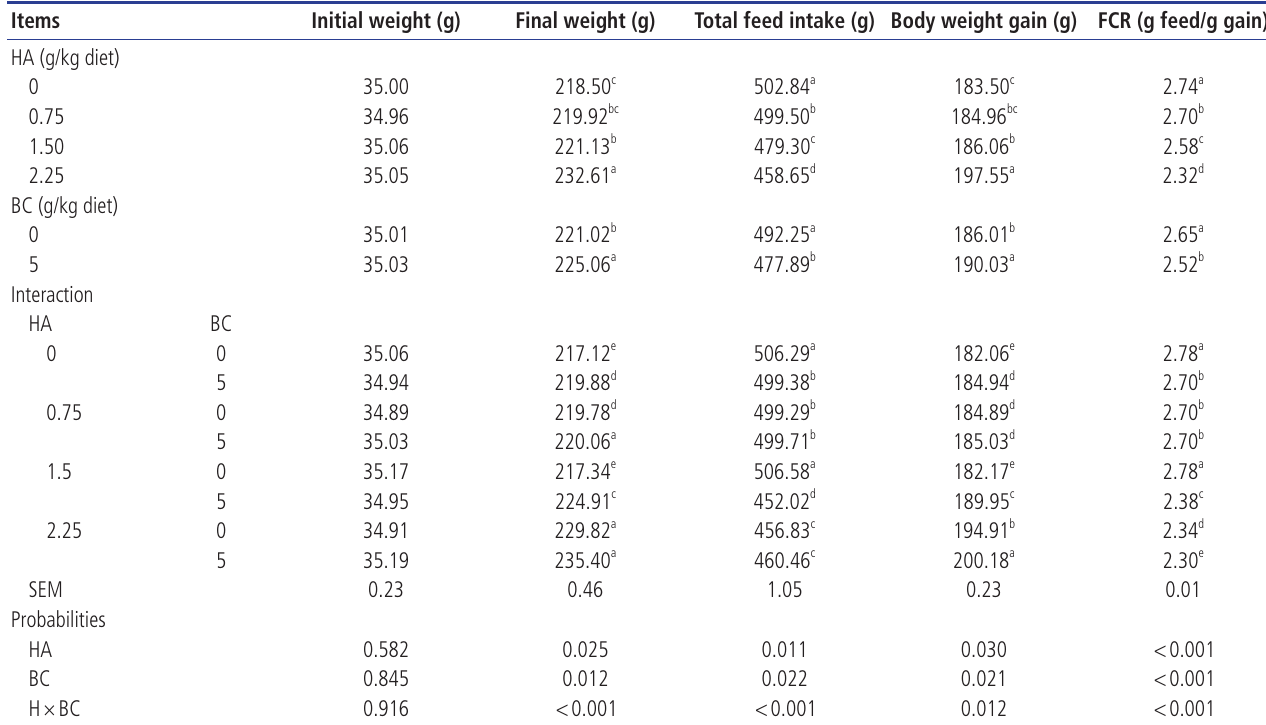
Table 2. Effect of dietary treatments on growth performance of quail Items Initial weight (g)